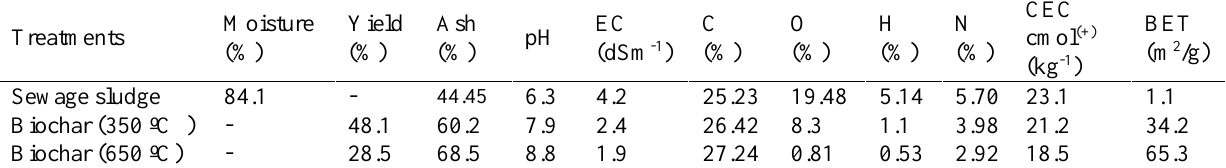
Table 2. Basic characterization of the sewage sludge and biocharspyrolyzed at 350 and 650 °C Treatments